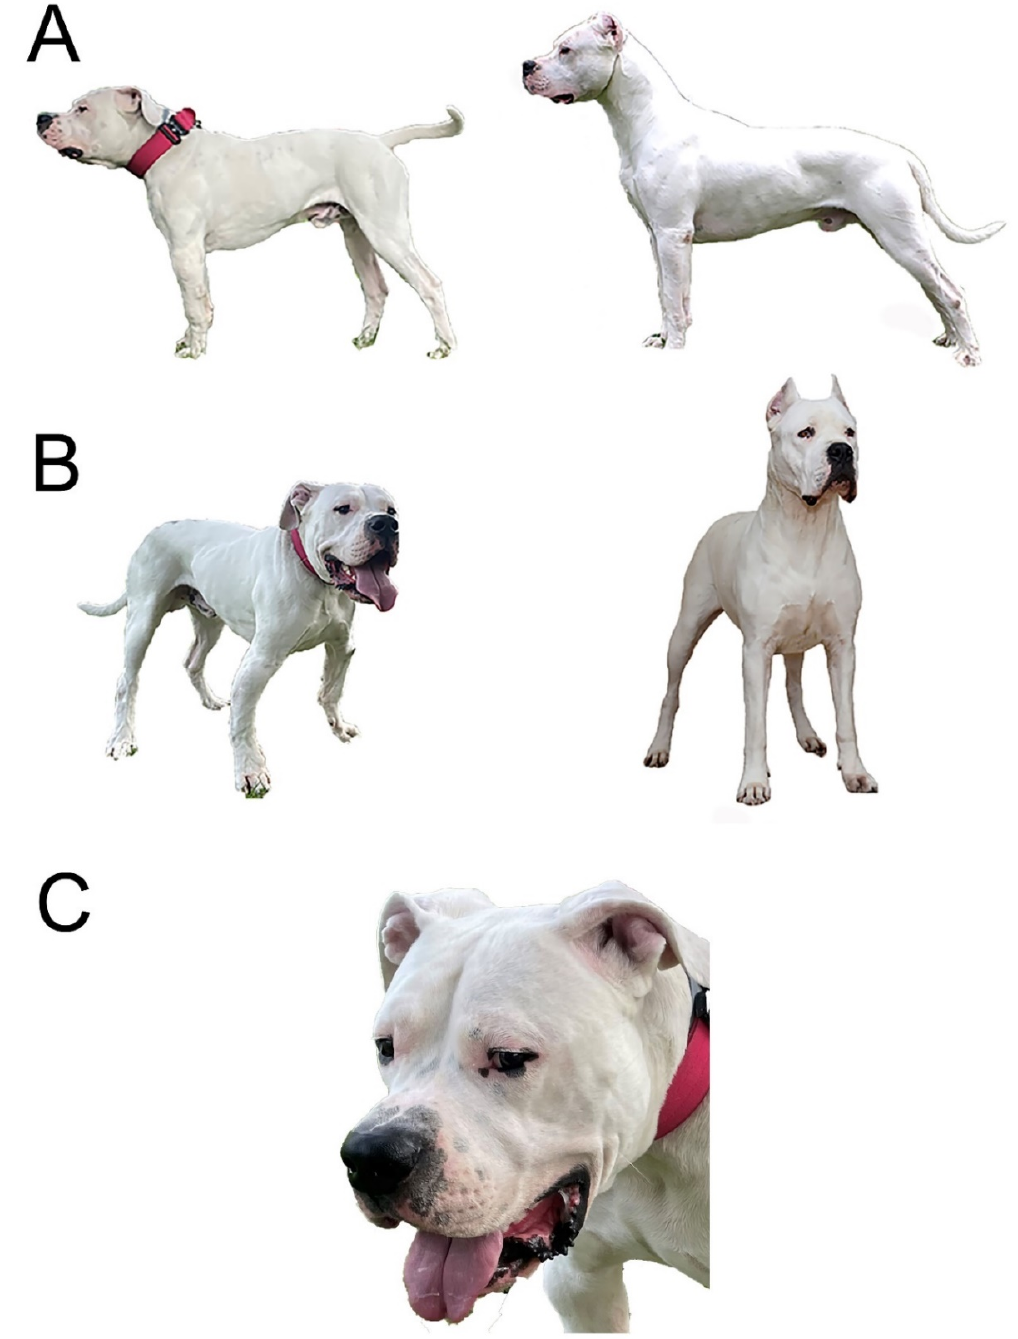
Figure 1. Morphology of the male affected dog at 2 years of age. The case subject (on the left) and a typical Dogo Argentino (on the right) according to the Federation Cynologique Internationale (FCI) standard. Please note that the affected dog had already undergone surgical corrections of the forelimbs before the photos were taken. ( A ) Side view: The height at withers of the case subject is 58.5 cm compared to the breed standard of 60–68 cm (ideal height 64–65 cm). The body length in the affected dog is also shorter. ( B ) View from a 45-degree angle: Disproportionally large head and forelimb angular abnormalities are evident. ( C ) Pronounced vertical groove between the eyes in the affected